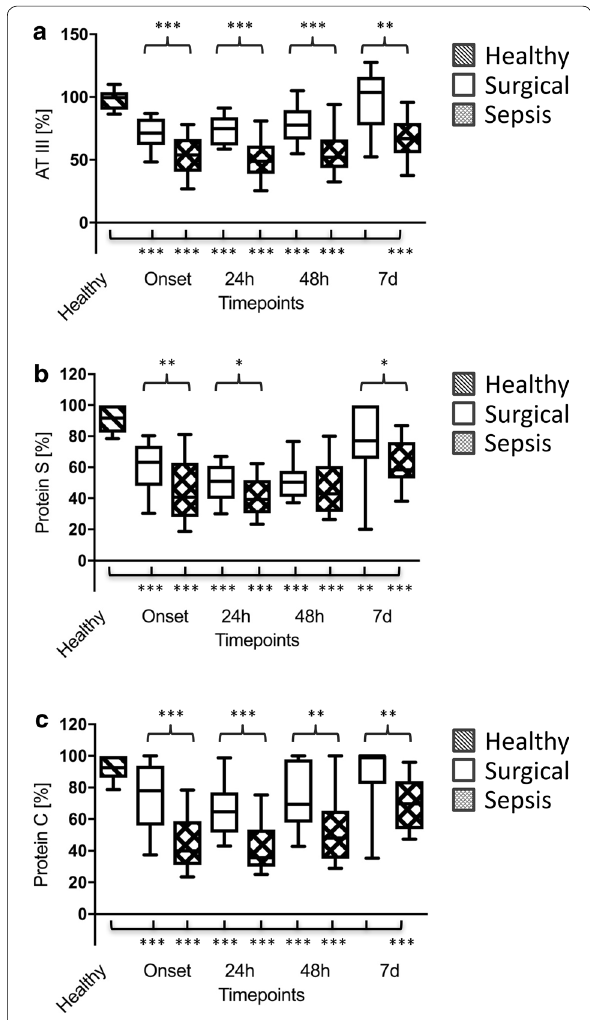
Fig. 1 Plasma levels of antithrombin (AT) III ( a ), protein S ( b ) and protein C ( c ) in healthy volunteers ( n 30; striped bars), surgical = patients ( n 30; white bars) and patients with septic shock ( n 30; = = squared bars). Data of patients with septic shock and surgical patients are presented for the timepoints onset (sepsis onset or immediately after the surgical procedure) as well as 24 h, 48 h and 7 d later, whereas blood samples from healthy volunteers were collected only once. Data in box plots are given as median, 25th percentile, 75th percentile with the 10th and 90th percentile at the end of the whiskers. A P value < 0.05 was considered statistically